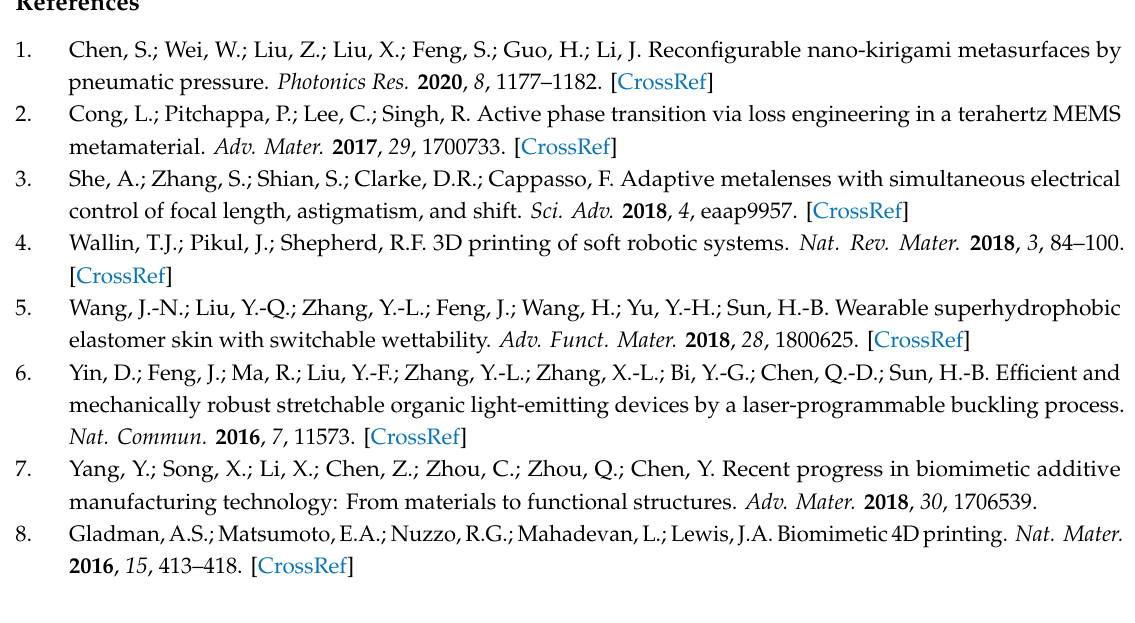
Video S1: Surface topography reconfiguration under pneumatic actuation. Figure S1: Microstructures fabricated using PDMS slices with di ff erent